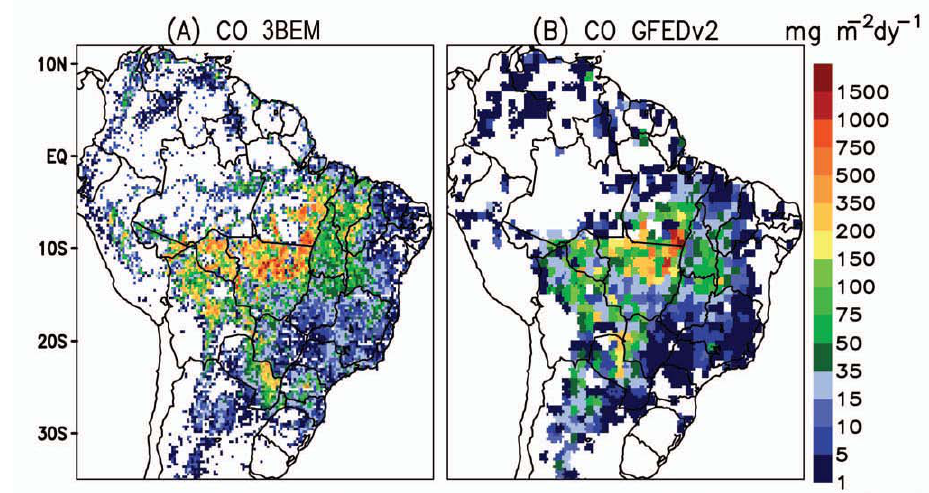
Fig. 1. Spatial distribution of the CO emission estimations in mgm − 2 dy − 1 averaged over 3 months (August-September-October 2002) from the two biomass burning inventories available within the PREP-CHEM-SRC system: (A) 3BEM, (B) GFEDv2. (Figure adapted from Longo et al.,